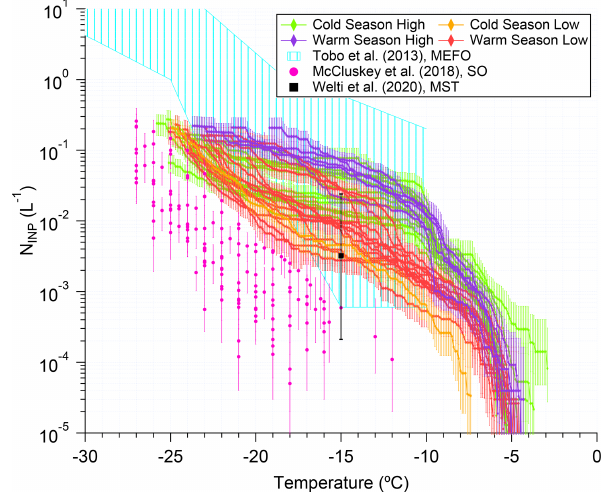
Figure 1. Cumulative N INP as a function of temperature shown as green (cold season high), orange (cold season low), purple (warm season high), and red (warm season low) lines, respectively. Er- ror bars show 95% confidence intervals. The N INP measured at the Manitou Experimental Forest Observatory (MEFO; Tobo et al., 2013), the Southern Ocean (SO; McCluskey et al., 2018a), and in the maritime South Temperate Zone (MST; only one value at − 15 ◦ C, Welti et al., 2020) are shown as cyan background, magenta dots, and a black square, respectively. Error bars in McCluskey et al. (2018a) show 95% confidence intervals. Error bars in Welti et al. (2020) show 80% of the observations (excluding 10% of highest and lowest